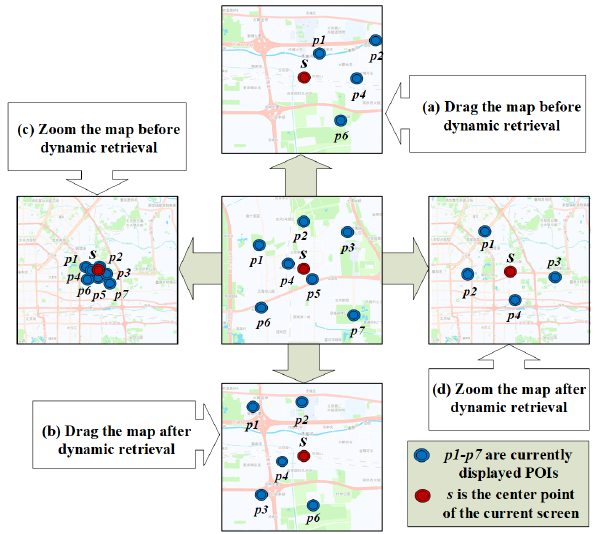
Figure 8. Comparison of POI display effect.